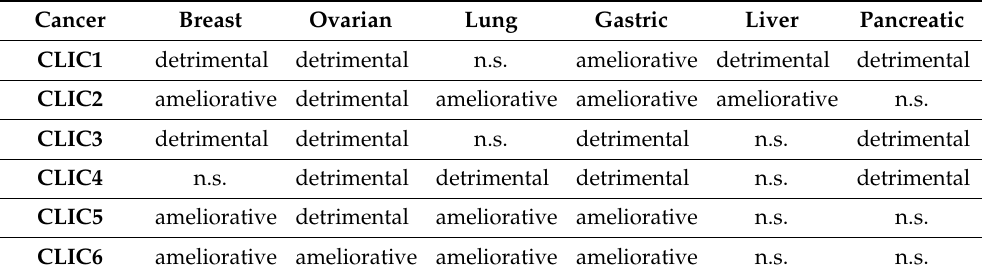
Table 2. Correlation between CLIC expression levels and cancer mortality. Effects of high CLIC expression levels on the survival of patients with cancer are simply summarized based on our own interpretation of the data reported by Gururaja Rao et al. [42]. n.s., not significant. Cancer Breast Ovarian Lung Gastric Liver Pancreatic CLIC1 detrimental detrimental n.s. ameliorative detrimental detrimental CLIC2 ameliorative detrimental ameliorative ameliorative ameliorative n.s. CLIC3 detrimental detrimental n.s. CLIC4 n.s. CLIC5 ameliorative detrimental CLIC6 ameliorative ameliorative ameliorative ameliorative n.s.